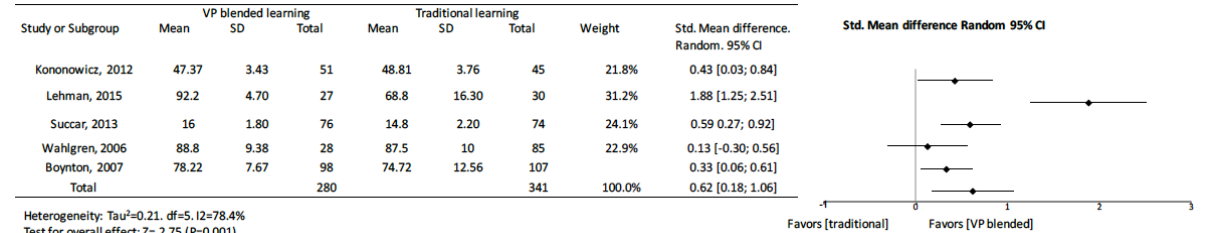
Figure 8. Forest plot of virtual patient blended learning to traditional learning comparison for knowledge outcomes. df: degree of freedom; CI: confidence